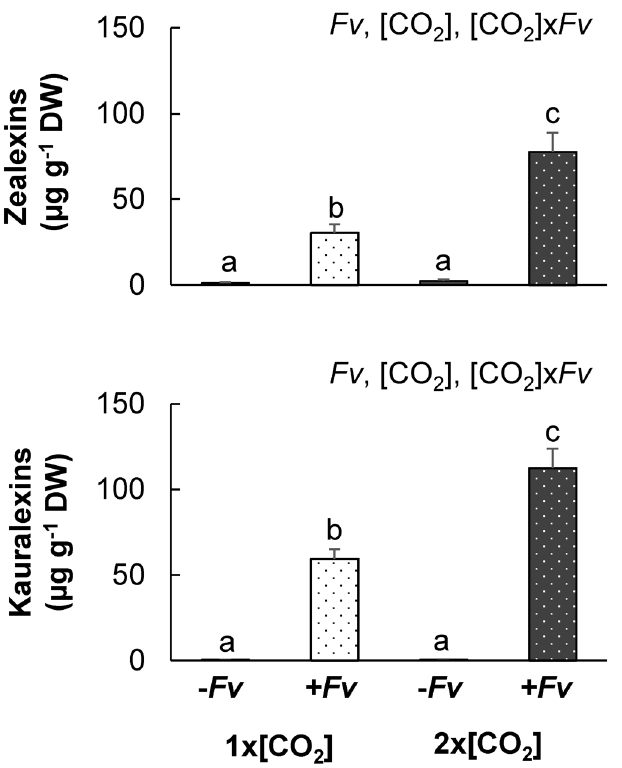
Fig 8. Effects of 2x[CO 2 ] and drought ( – H 2 O) on the accumulation of maize terpenoid phytoalexins following F . verticillioides ( Fv) inoculation. Average concentration ± SEM of (a) total zealexins and (b) kauralexins in maize stalks grown at 1x[CO 2 ] or 2x[CO 2 ] with drought (-H 2 O) treatment two days after mock inoculation (- Fv ) or F . verticillioides inoculation (+ Fv ) was determined. Statistically significant factors and interactions are included at the top right corner of each graph 2x2 ([CO 2 ]x Fv ) ANOVA. Since the interaction between the contributing factors was significant, a Tukey- Kramer HSD test was performed to determine differences between each mean. Letters above standard error of mean (SEM) bars indicate significant differences (n = 4, P <